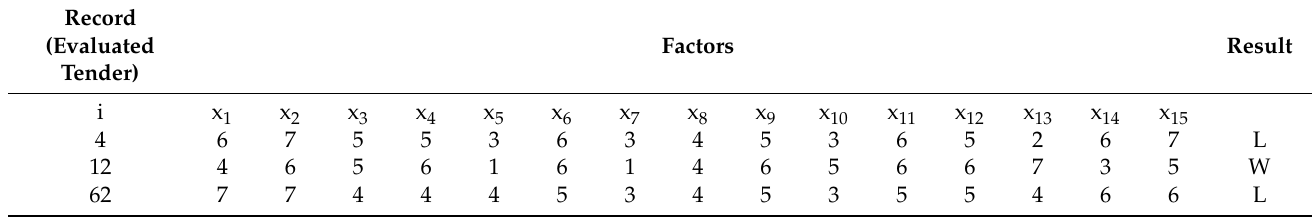
Table 2. Selected database